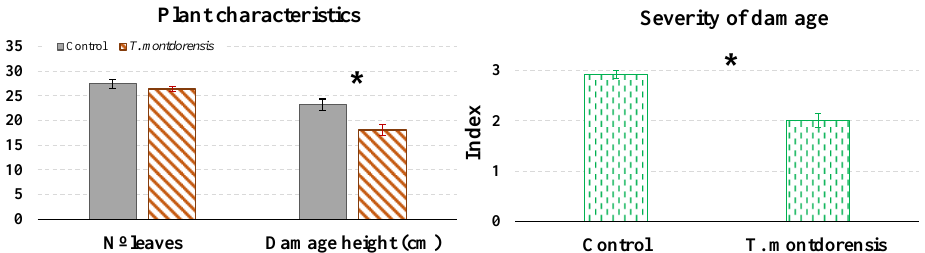
Figure 3. Densities of TRM and T. montdorensis (mite-days) per four leaves in the experiment with cages, autumn 2018. Counts were made using sticky tape or destructively by washing four leaves; the density of the collected mites was measured using a stereomicroscope (25 × ). Significant differences between treatments are indicated by capital letters ( p < 0.05).